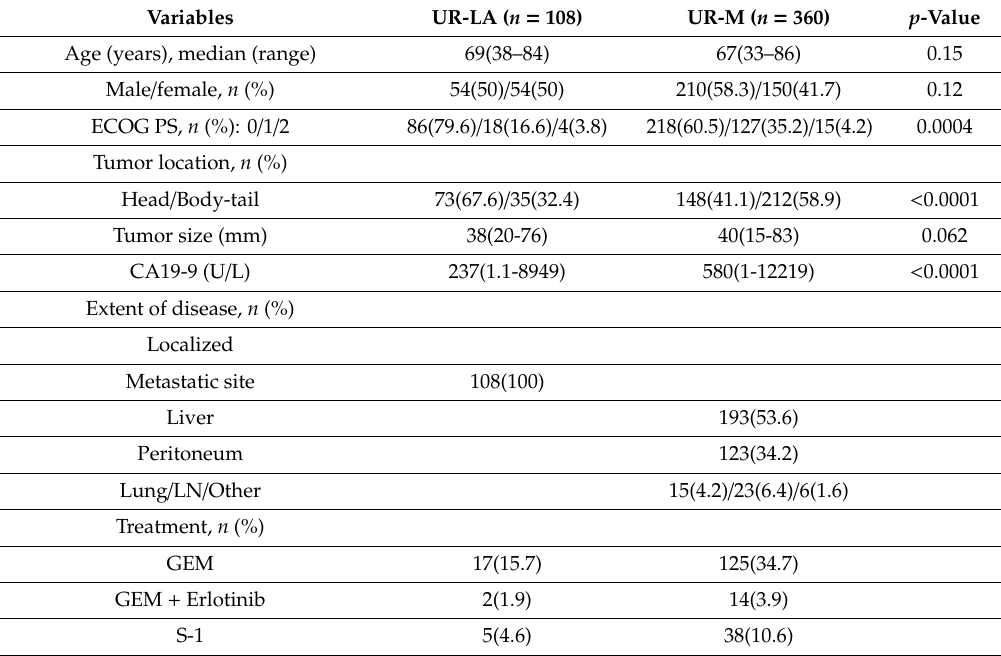
Table 1. Baseline patient